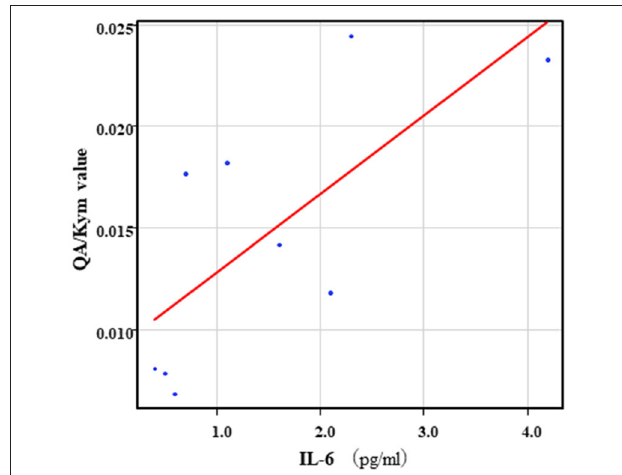
FIGURE 7 | Association between serum IL-6 levels and serum QA/Kyn value in the healthy control group. A positive correlation was found between the serum levels of IL-6 and the serum levels of QA/Kyn value ( r = 0.77, p = 0.021) in the healthy control group.